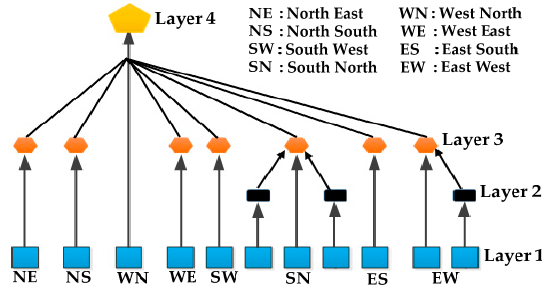
Figure 11. Logically separated 4-level hierarchical distributed network [57].